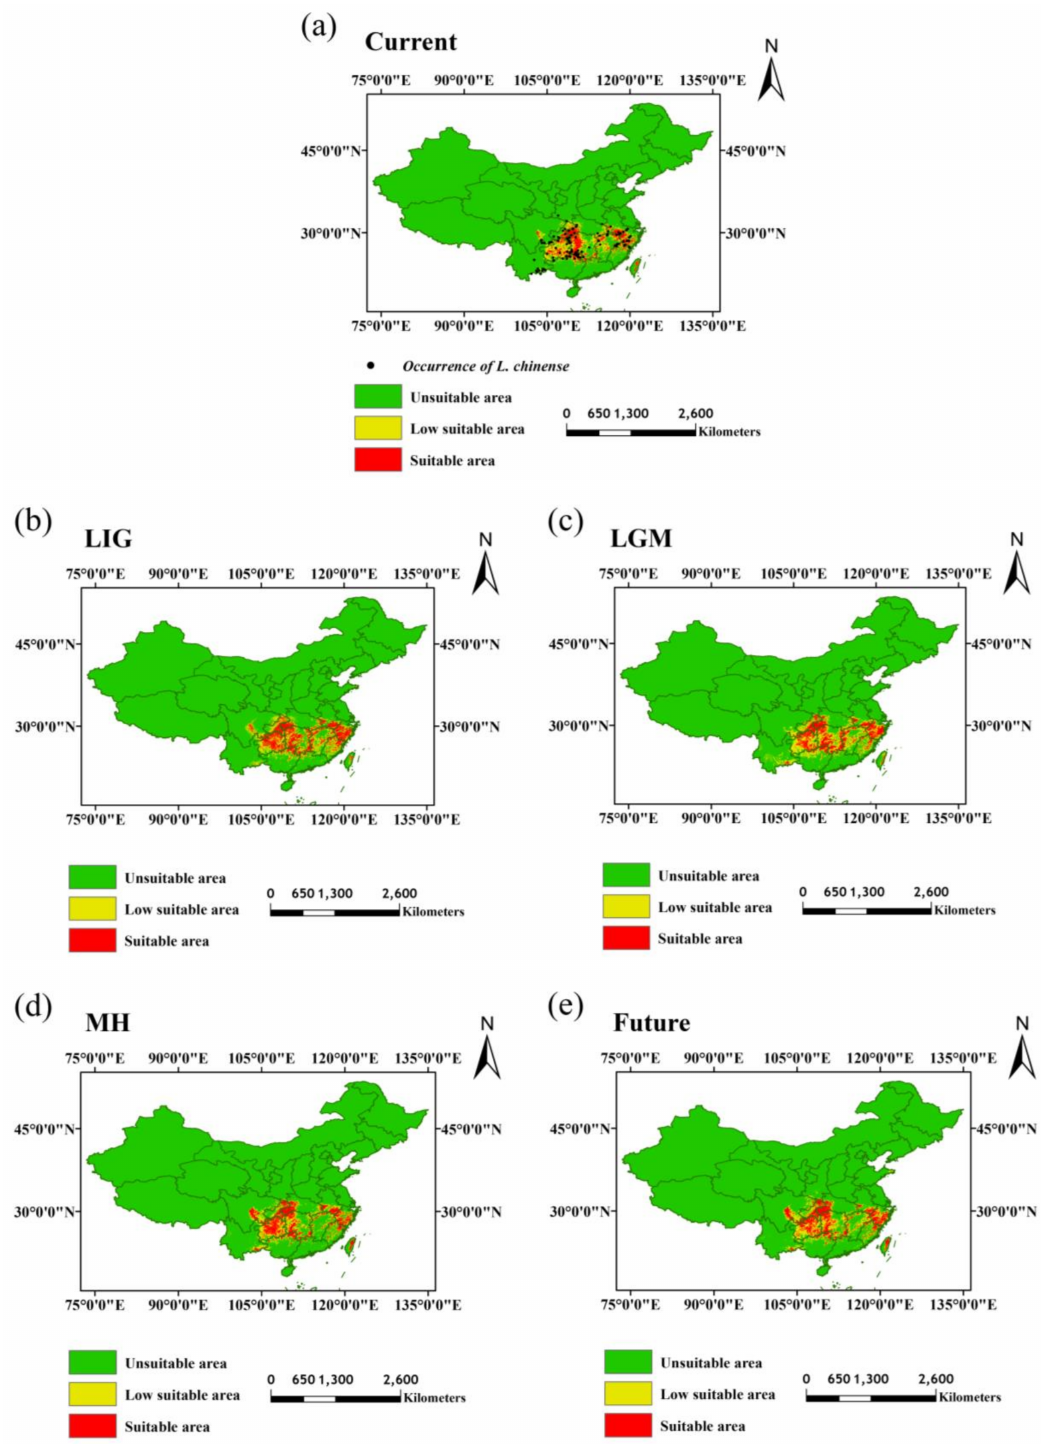
Figure 7. Comparisons of current, past, and future distributions of L. chinense projected by species distribution model (SDM) using MaxEnt. ( a ) Current distribution (black dots represent data points used in the modeling). ( b ) LIG (Last interglacial) distribution. ( c ) LGM (Last glacial maximum) distribution. ( d ) MH (Mid-Holocene) distribution. ( e ) Future (2080)